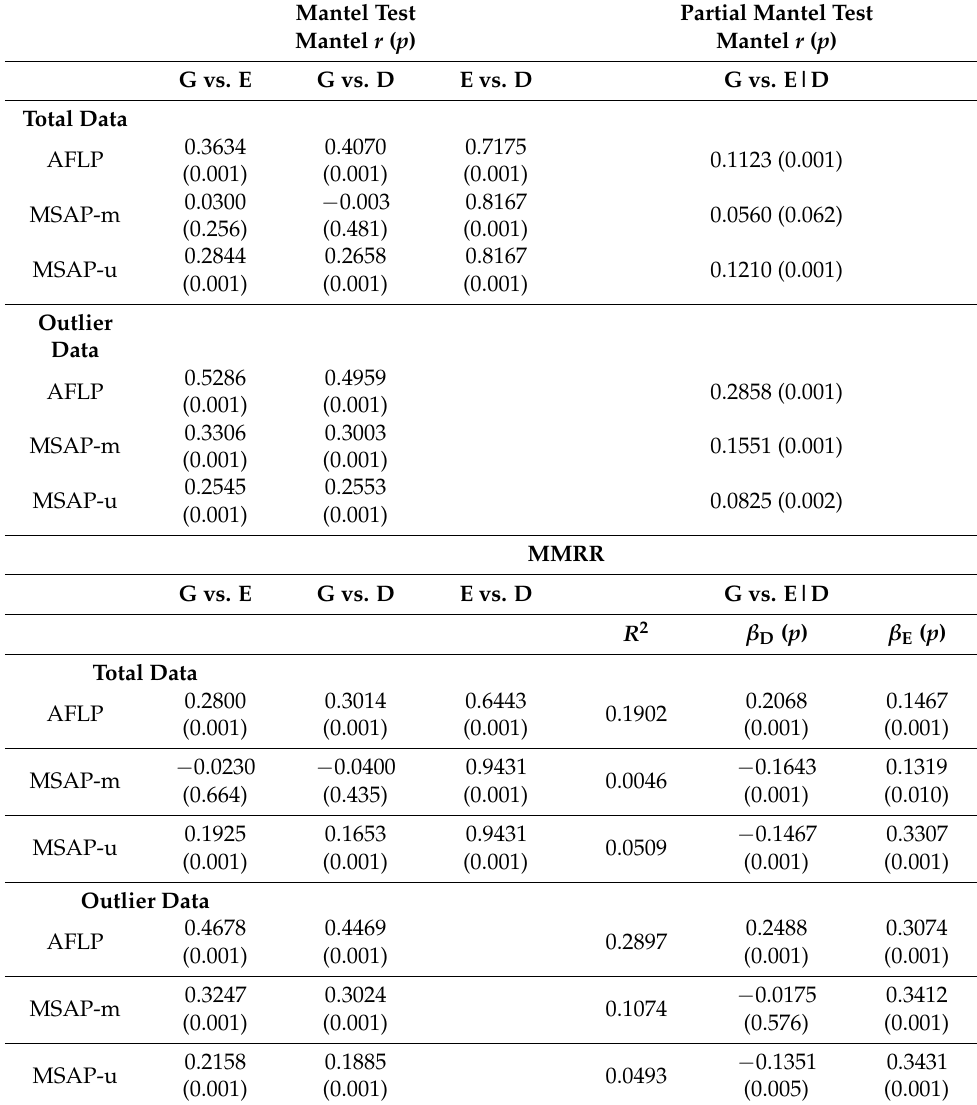
Table 4. Isolation-by-environment and isolation-by-distance tested using Mantel test, partial Mantel tests, and multiple matrix regression with randomization (MMRR). Euclidean distance matrices were generated based on AFLP, MSAP-m, and MSAP-u (G), geography (D), and environment (E). MMRR was used to infer the effects of geographic ( β D ) and environmental ( β E ) distances on genetic (AFLP) and epigenetic (MSAP-m and MSAP-u) distances. R 2 represents the total amount of variation explained by both geographic and environmental factors. When outlier datasets were used, strong adaptive divergence can be inferred if significance was found controlling for geographic effect. Mantel Test Partial Mantel Test Mantel r ( p ) Mantel r ( p ) G vs. E G vs. D E vs. D G vs.